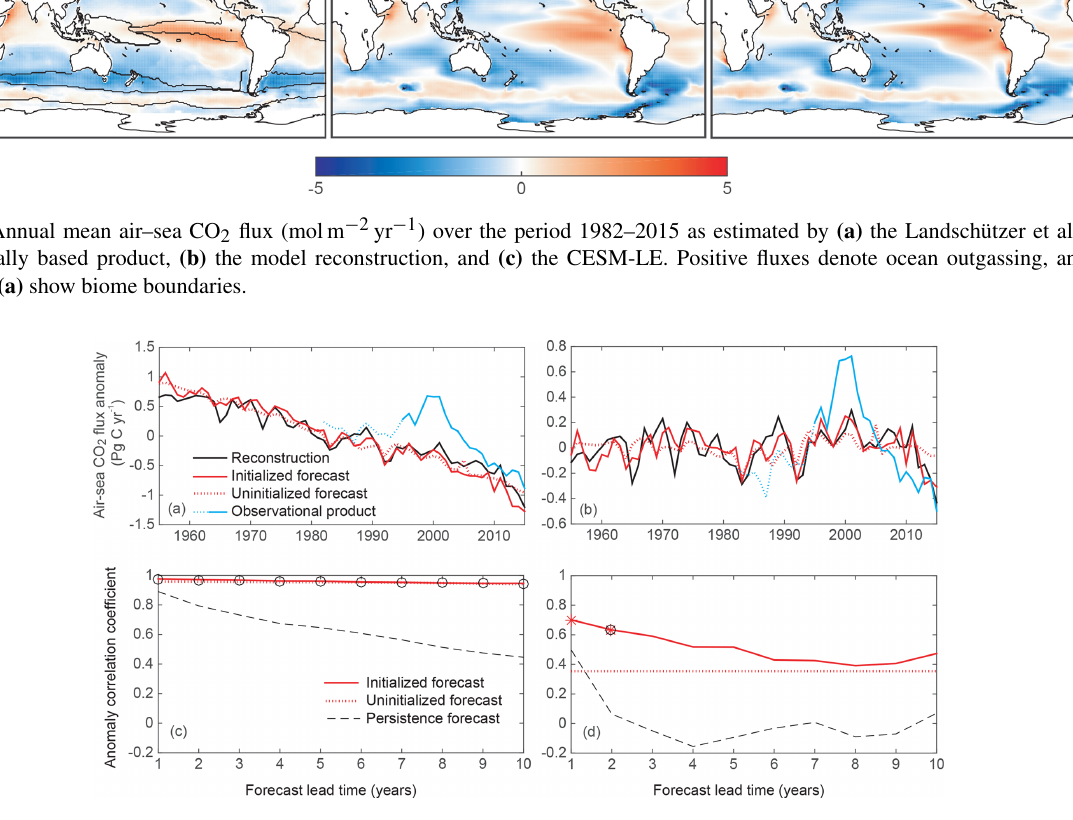
Figure 3. (a) Temporal evolution of the globally integrated air–sea CO 2 flux anomaly, as estimated by the (black) reconstruction, (red) CESM-DPLE initialized forecast, (red dotted) CESM-LE uninitialized forecast, and (blue) Landschützer et al. (2016) observationally based product. The CESM-DPLE time series is the drift-corrected, ensemble mean forecast anomalies over lead year 1; the reconstruction, unini- tialized forecast, and observational product have been transformed to anomalies by subtracting their respective climatological means. Ob- servations prior to 1995 are dotted due to lower observation density. Positive anomalies indicate anomalous ocean outgassing. (b) Same as (a) , but with long-term linear trends removed from each time series. (c) Predictability of globally integrated CO 2 flux as a function of lead time, as indicated by the correlation coefficient of CO 2 flux anomalies from the (red) CESM-DPLE initialized forecast, and the (red dotted) CESM-LE uninitialized forecast with the reconstruction. The black dashed line indicates the correlation coefficient of the persistence forecast as a function of lead time. Red asterisks (black circles) on the initialized forecast indicate predictability that is statistically different from the uninitialized (persistence) forecast at the 95% level using a z test. (d) Same as (c) , but with linear trends removed from each time